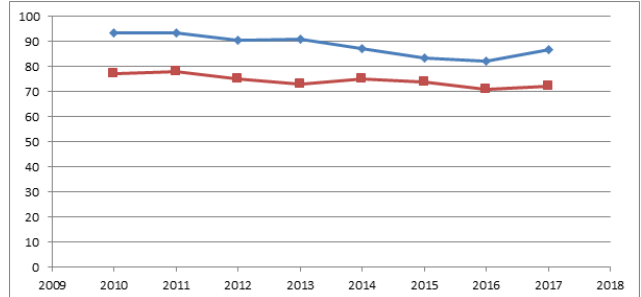
Figure 8. Dynamics of the coefficient of variation (bottom) and the weighted coefficient of variation of the GDP per capita of Russia in 2010–2017, %.